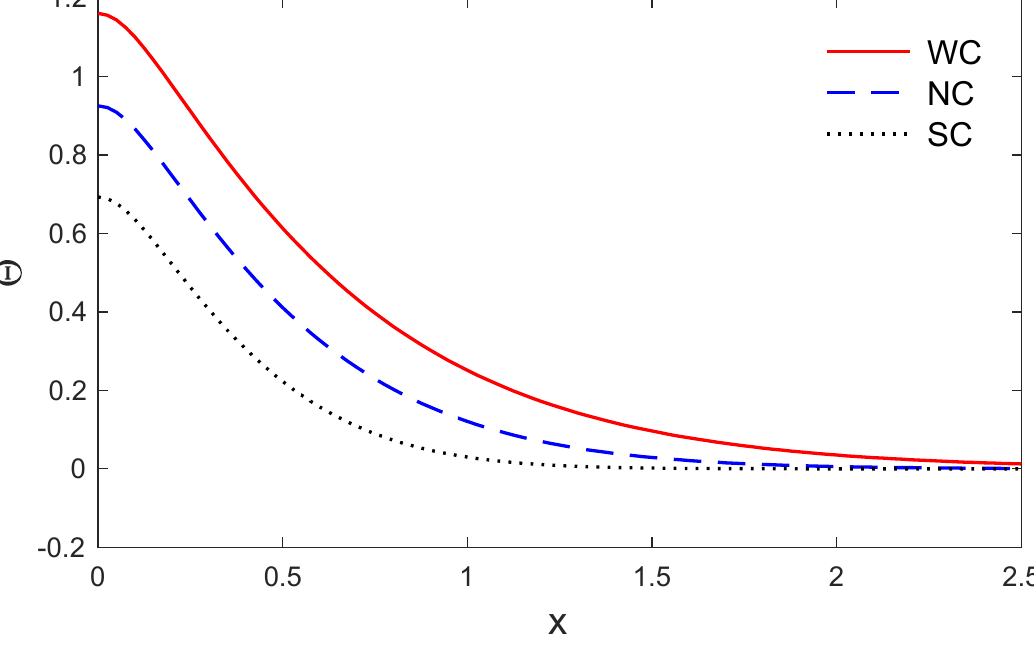
Figure 2. The variation of temperature Θ via x and y = 0.4 for strong normal and weak conduc- tivities.